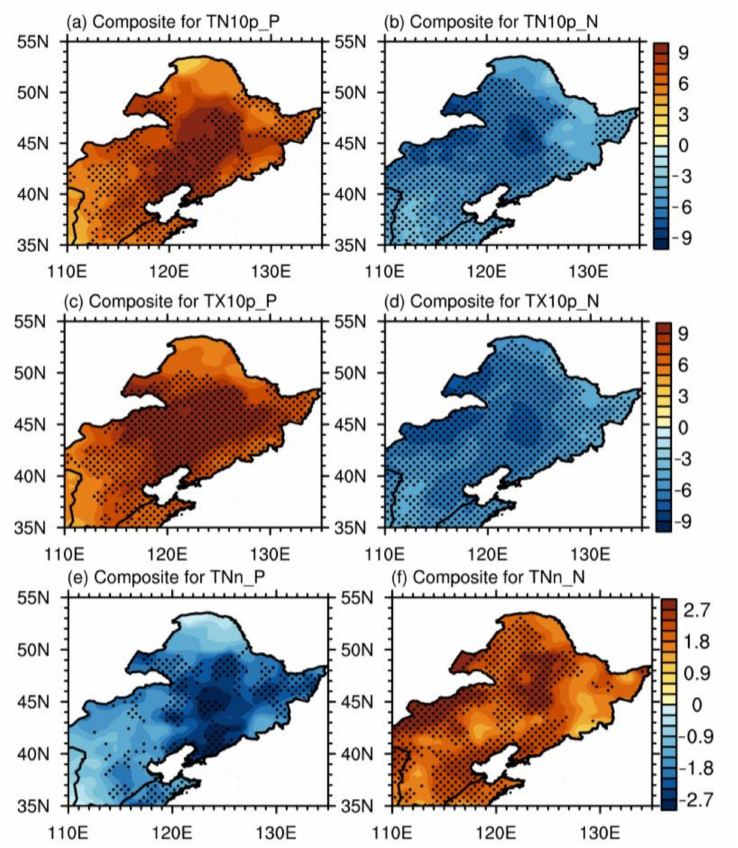
Figure 5. Composite anomalies of TN10p (unit: days), TX10p (unit: days), and TNn (unit: ◦ C) in ( a , c , e ) TN10p_IAP and ( b , d , f ) TN10p_IAN years. The dotted region indicates significance at the 95% level from the t